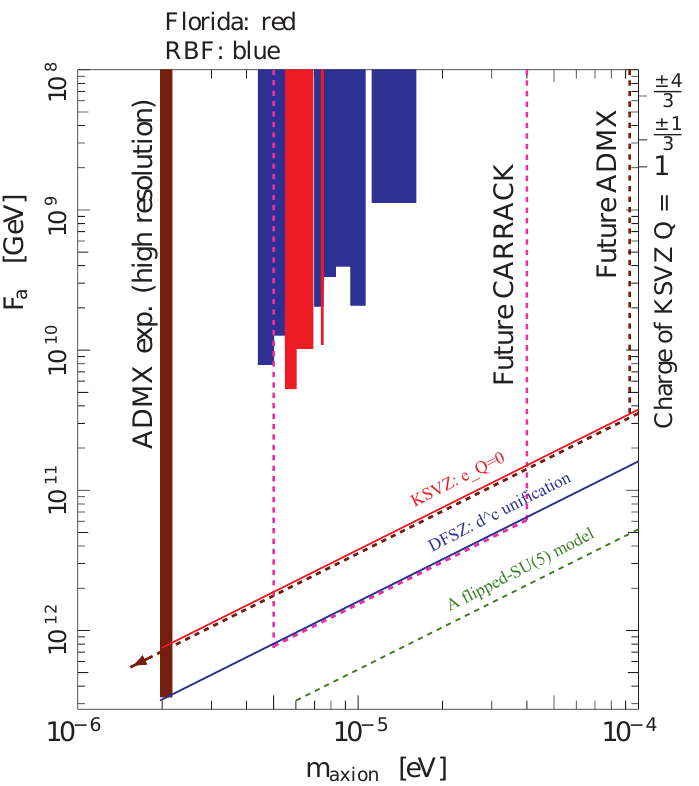
Figure 1 . Experimental constraints on the axion parameters, f a ; m a . Adapted from